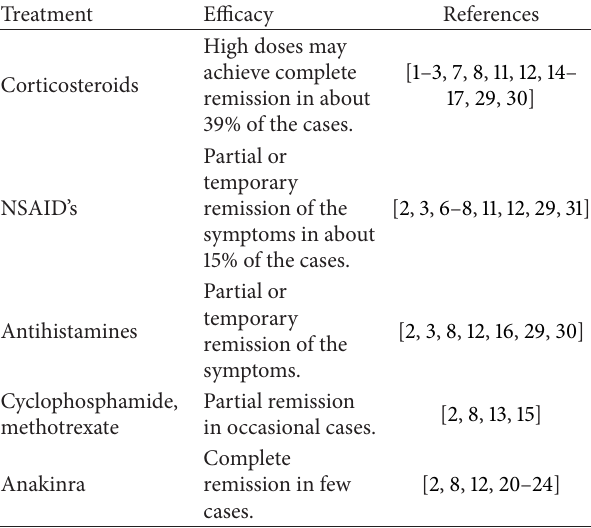
Table 1: Laboratories at admission. Table 2: Common therapeutic strategies for Schnitzler’s